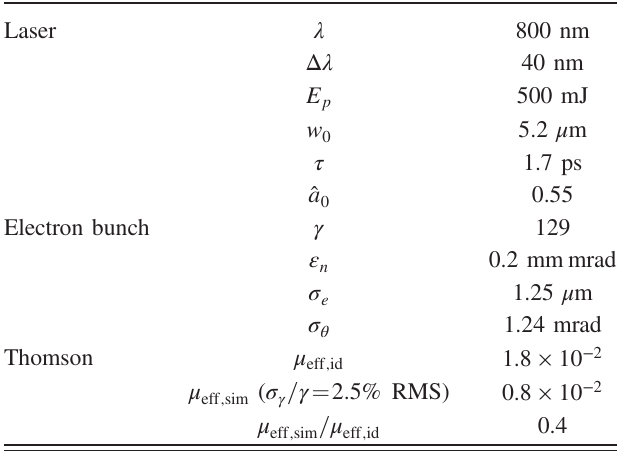
TABLE II. Design parameters for laser and electron bunch, as well as effective photon productions, where μ is calculated eff ; id according to Eq. (8) and μ is the maximum simulation result eff ; sim of the scenario in Fig. 7 of 10% bandwidth contribution.